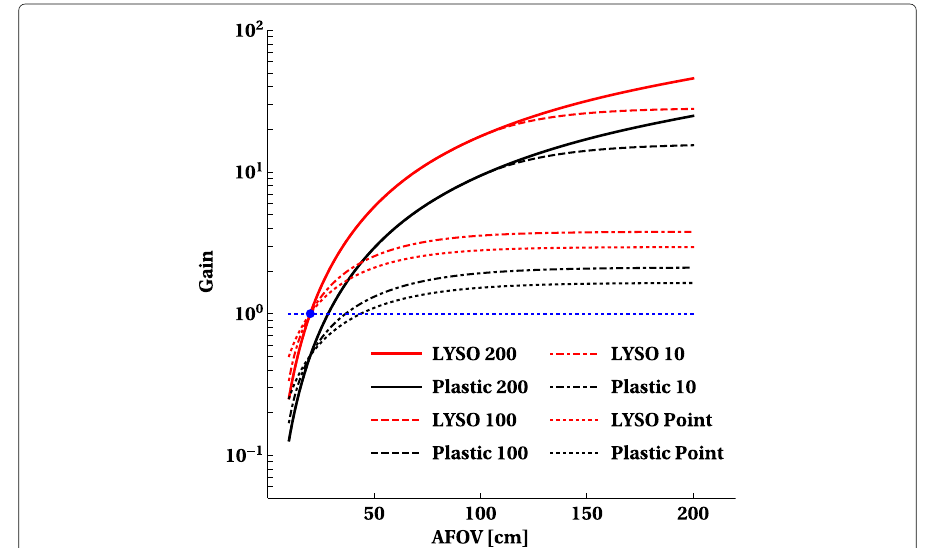
Fig. 15 Sensitivity gain, with respect to 20-cm length LYSO PET, as a function of the axial length for LYSO (2 cm thick) and plastic (two 3-cm-thick layers) detectors. Results for a point-like, single organ (10 cm), as well as 100-cm and 200-cm sources are